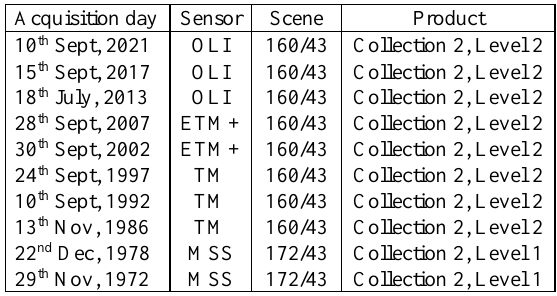
This contribution has been peer-reviewed. https://doi.org/10.5194/isprs-archives-XLIII-B3-2022-69-2022 | © Author(s) 2022. CC BY 4.0